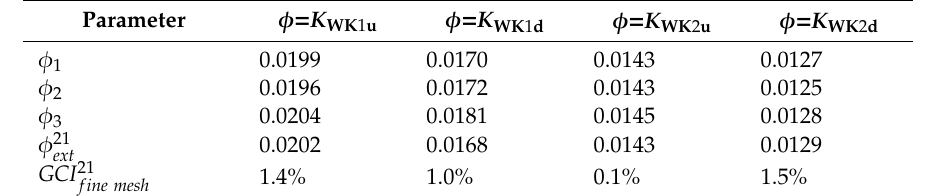
Table 2. Discretization uncertainty study using Richardson extrapolation following Reference [37]. ∅ 1 , ∅ ∅ ffi cients obtained with N 2 , and 3 are the WK coe 1 , N 2 , and N 3 mesh, respectively.